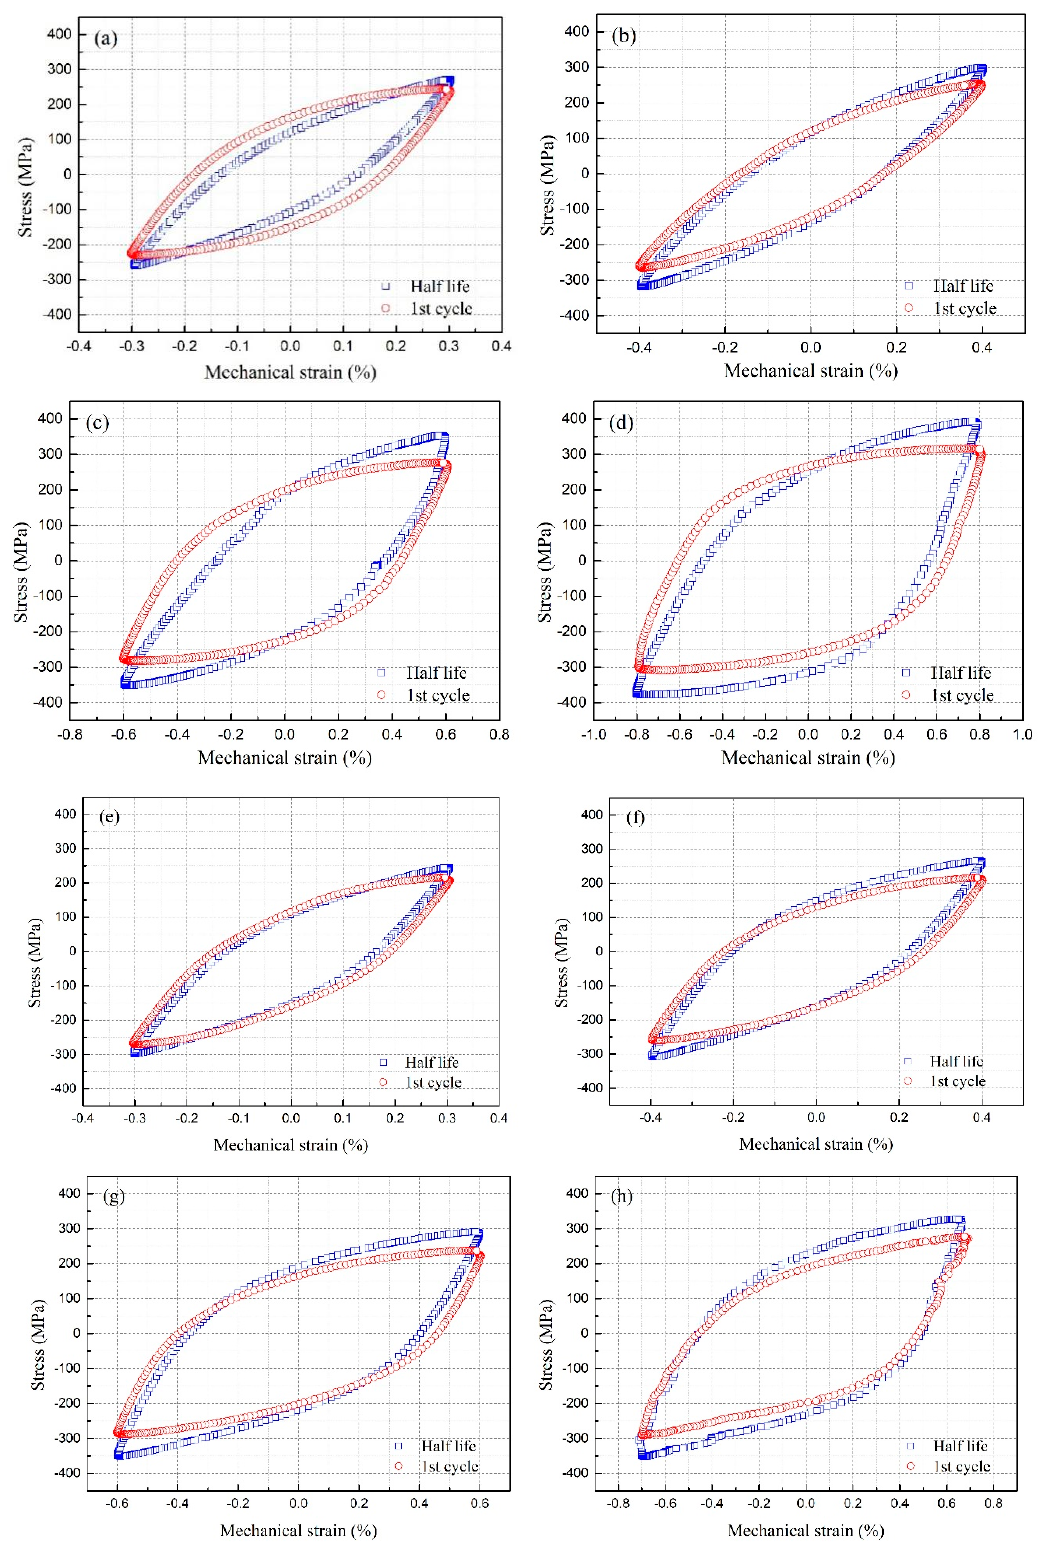
Figure 7. Stress-mechanical strain hysteresis loops of as-received steel: ( a ) 0.3%; ( b ) 0.4%; ( c ) 0.6%; ( d ) 0.8%; and aluminized steel: ( e ) 0.3%; ( f ) 0.4%; ( g ) 0.6%; ( h ) 0.7%.